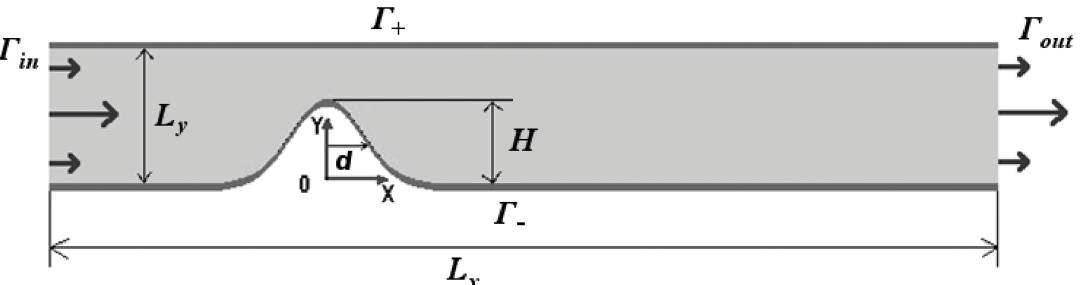
Fig 1. Geometry of the vessel fragment. L x , L y and H correspond to vessel length, cross section diameter and plaque height. Γ in and Γ out denote inlet and outlet boundaries respectively. Γ + and Γ − refer to upper and lower vessel walls